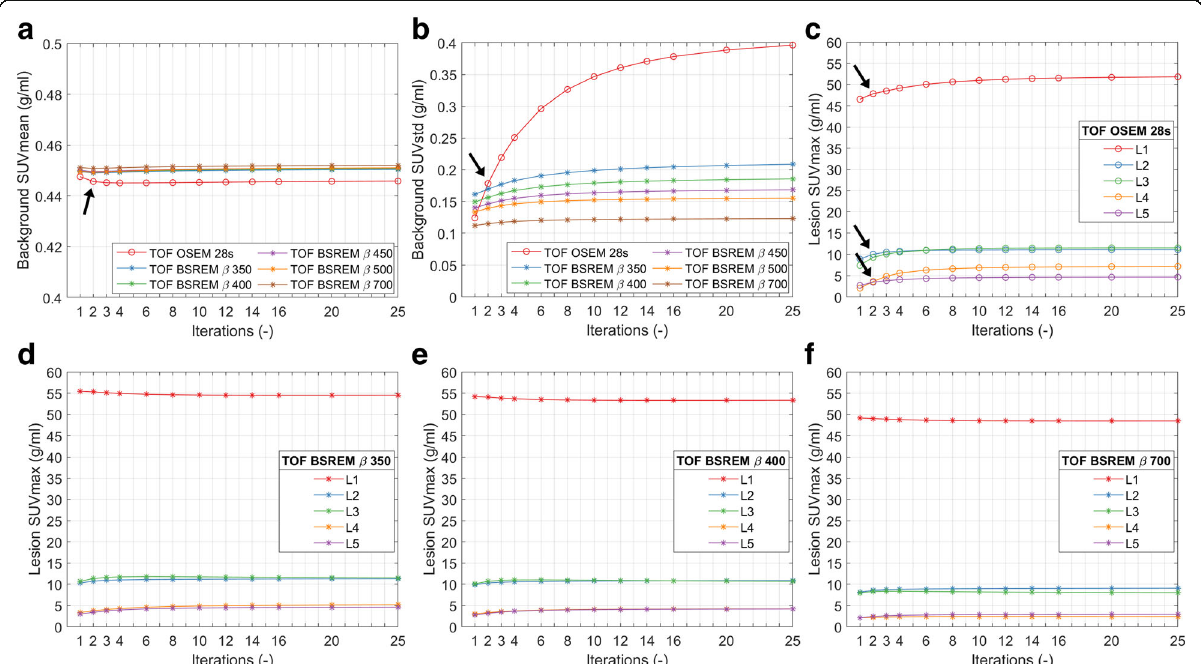
Fig. 1 Example dataset showing the effect of increasing iterations. The first two panels show the background SUVmean ( a ) and the SUVstd ( b ), as a function of the number of iterations, for TOF OSEM with 28 subsets and for TOF BSREM with regularization parameter β = 350, 400, 450, 500, and 700. The remaining 4 panels show the lesion SUVmax as a function of the number of iterations for 5 lesions (L1 – L5) for TOF OSEM with 28 subsets ( c ) and for TOF BSREM with regularization parameter β = 350 ( d ), 400 ( e ), and 700 ( f ). The arrows indicate the default reference TOF OSEM reconstruction with 28 subsets and 2 iterations. SUV standardized uptake value, SUVmean the average value of the voxels in the background ROI, SUVstd the standard deviation of the values of the voxels in the background ROI, SUVmax the average of the hottest 5 voxels in the lesion, TOF time-of-flight, OSEM ordered subset expectation maximization, BSREM block sequential regularized expectation